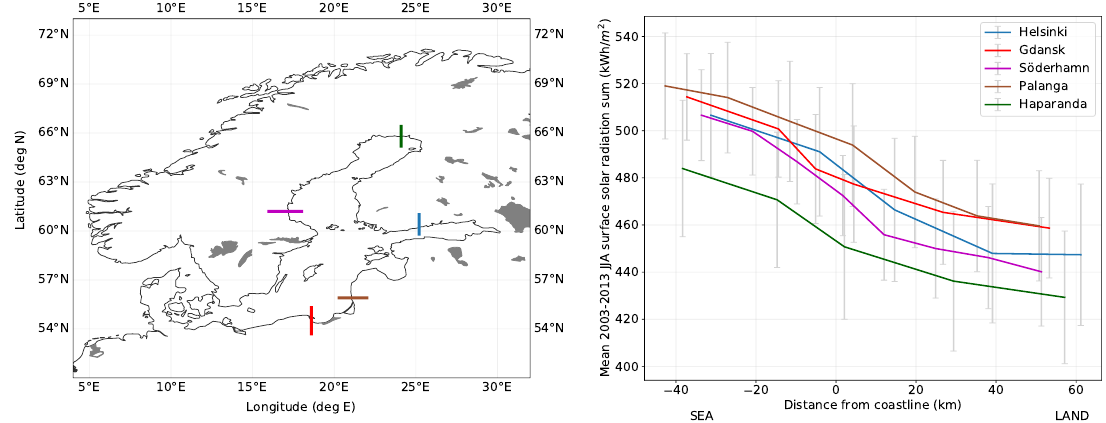
Figure 2. ( left ) Map showing the location of the transects for which ( right ) the climatological summer (JJA) SSR according to CLARA-A2 is presented as a function of distance to the coastline. The light grey error bars indicate the standard deviation of the annual summer